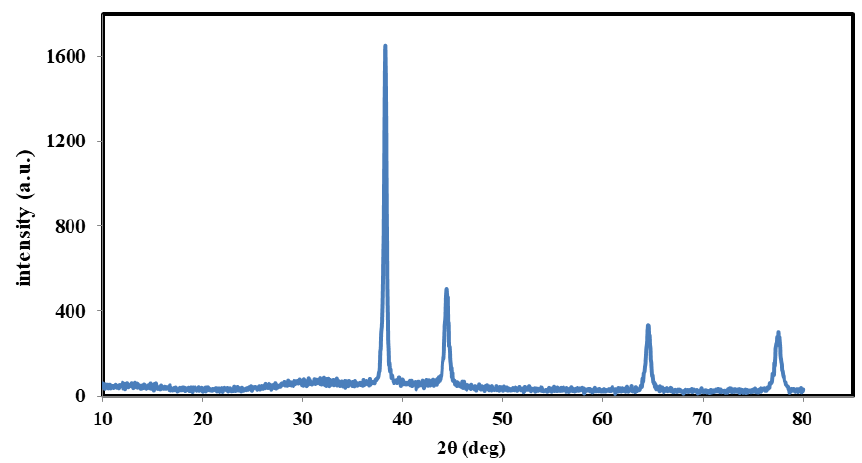
Figure 1. XRD diagram showing the crystal growth planes of prepared silver nanowires.